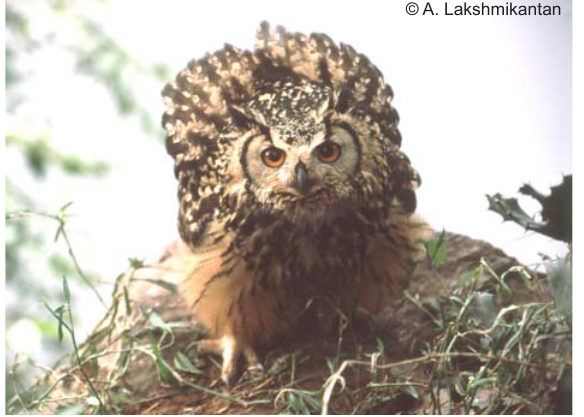
Image 6. Close-up of ruffled plumage.